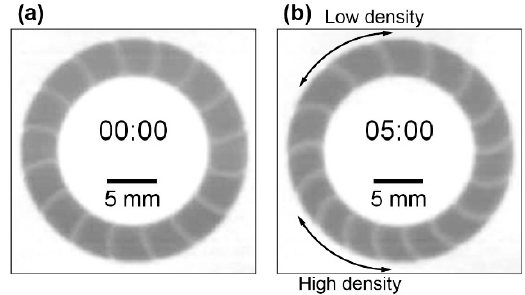
Figure 5. Snapshots at t = ( a ) 0 s and ( b ) 300 s. Under the initial condition, 16 chemical waves were distributed with equivalent intervals (homogeneous). Oppositely, low- and high-density regions appeared at t = 300 s. The arrows in ( b ) indicate a length of 10 mm. In the low-density region, there were two chemical waves at 10 mm, while three waves were observed in the high-density region.